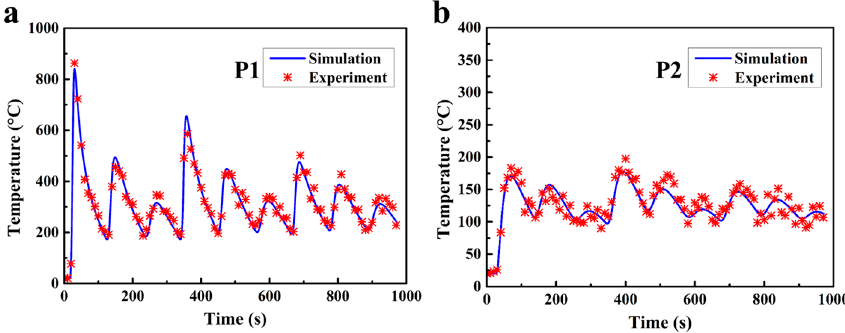
Figure 6. Temperature verification on the measuring positions of ( a ) P1 and ( b ) P2.